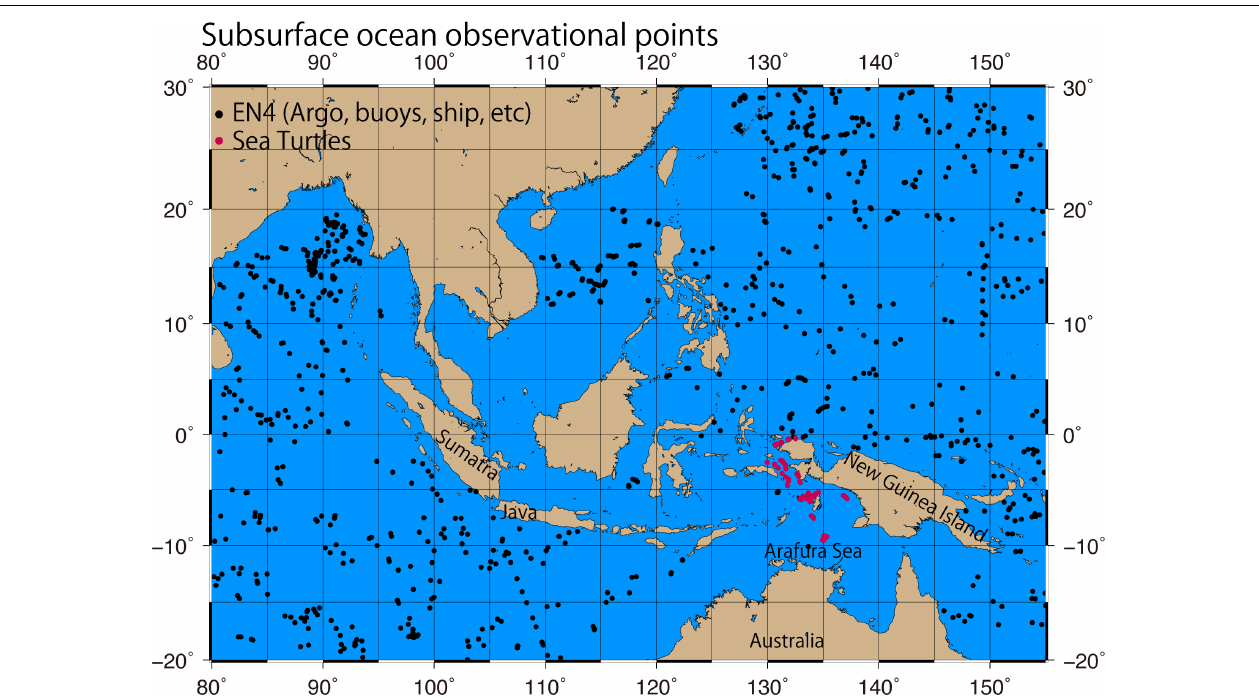
FIGURE 2 | Horizontal map of the subsurface ocean observational points in 50–150 m-depth that are assimilated to the SINTEX-F2 seasonal prediction system during June–August 2017 (black dots, EN4 datasets; red dots, measurements from sea turtles).